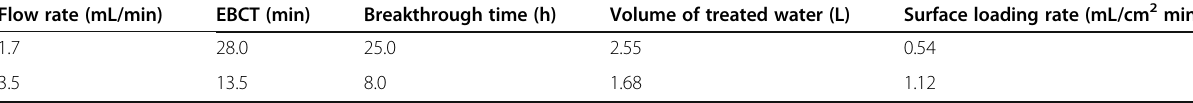
Table 3 Effect of different flow rate on important operating parameters of continuous column tests using GOFeZA Flow rate (mL/min)